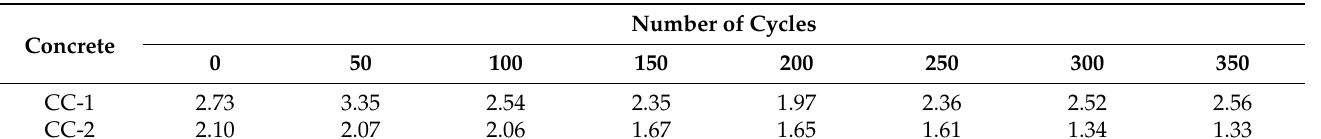
Table 9. Characteristics of the change in the relative measure of the dispersion of the average compressive strength of concrete CC-1 and CC-2—scheme A.